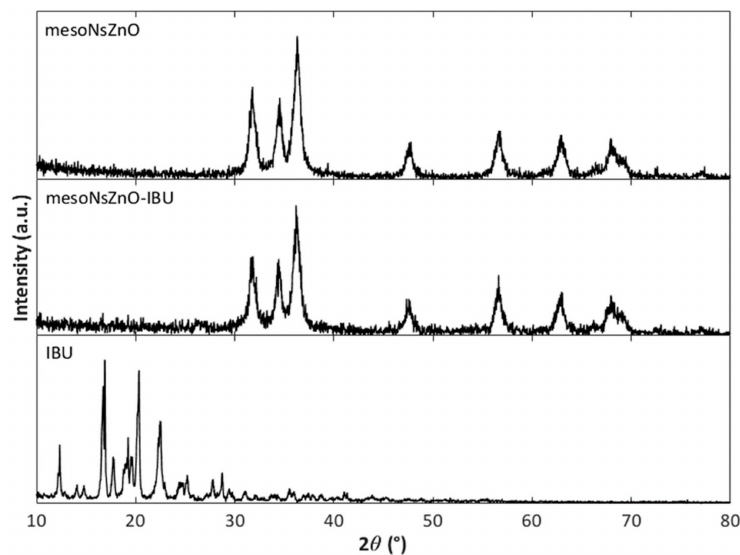
Figure 7. XRD patterns: MesoNsZnO carrier, mesoNsZnO-IBU system obtained after a contact time of 24 h,